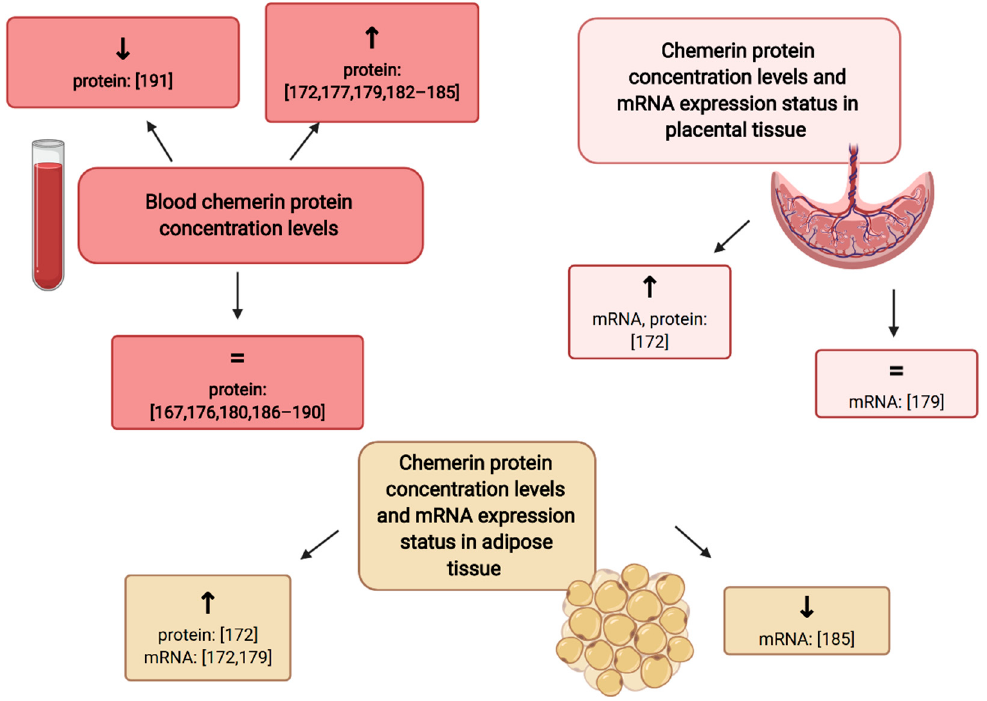
Figure 2. The graphical summary of data concerning chemerin concentration and chemerin mRNA expression levels in GDM patients as compared to control patients. ↑ increase in parameter level as compared to control [172,177,179,182–185]; ↓ decrease in parameter level as compared to control [191]; = : no significant alterations observed as compared to control [167,176,180,186–190] (Created with BioRender.com).